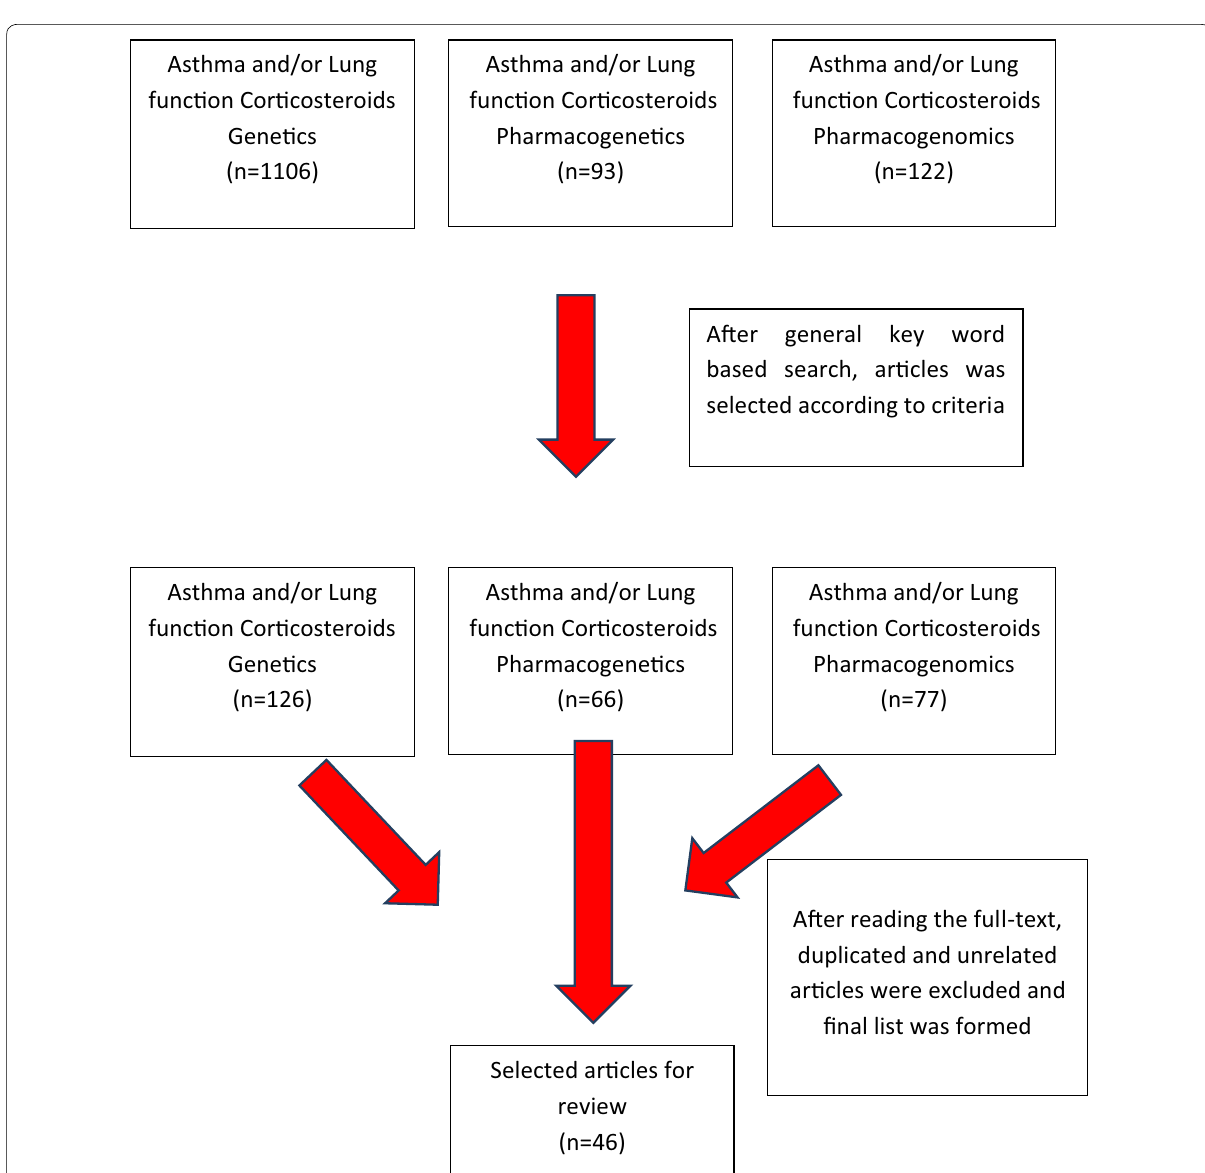
Fig. 1 Flowchart for the inclusion of ICS pharmacogenomic